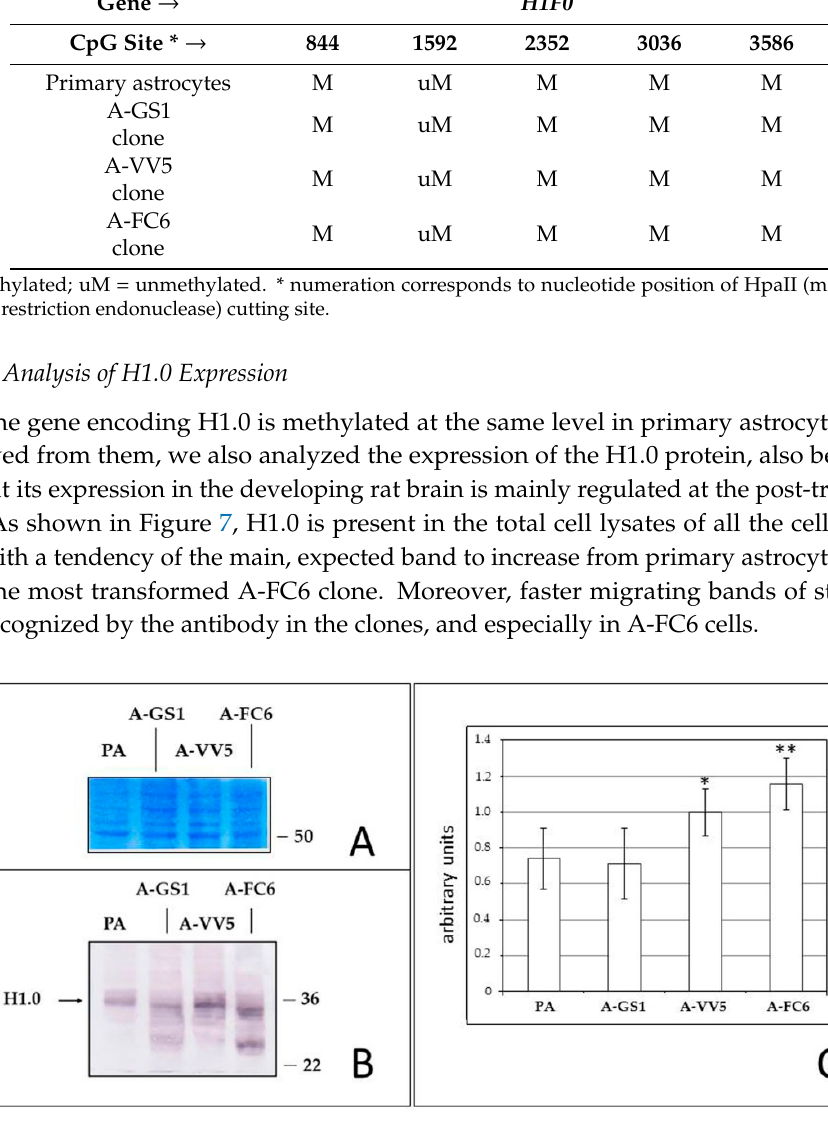
Table 2. Promoter CpG methylation of H1F0 , in the four cell populations.